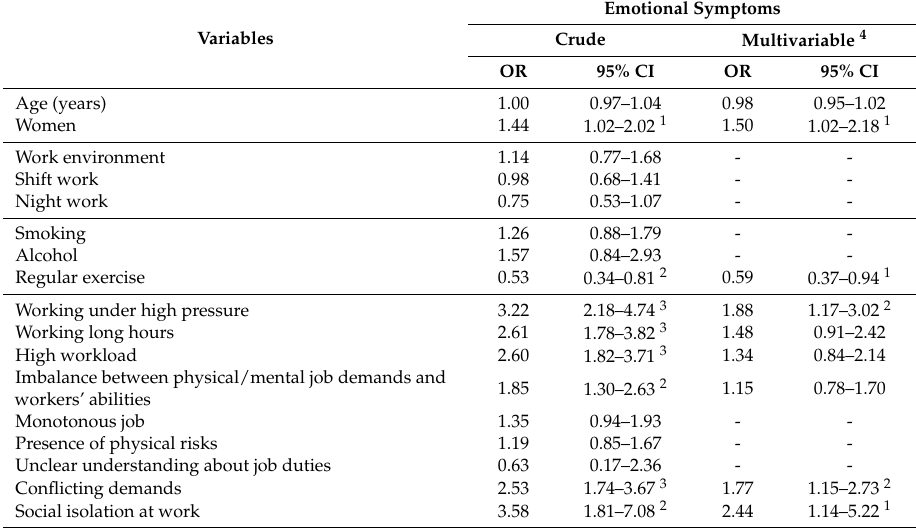
Table 3. Univariate and multivariate logistic regression analysis of factors influencing emotional symptoms.